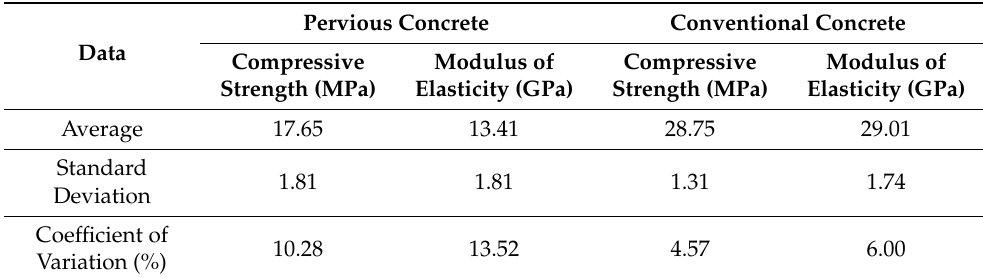
Table 10. Results of compressive strength and modulus of elasticity obtained for the cylindrical specimens.